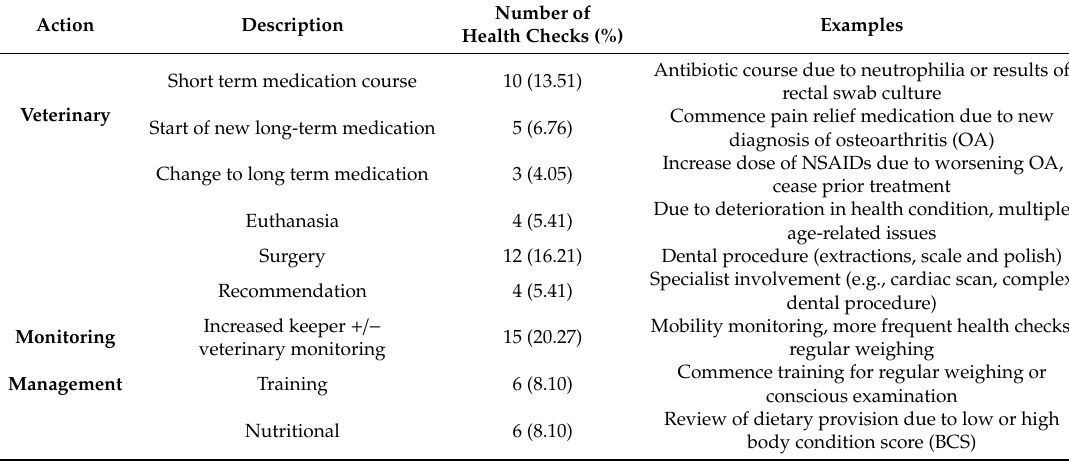
Table 7. The number and percentage (%) of health checks which resulted in veterinary intervention, increased monitoring and / or management changes, with examples of